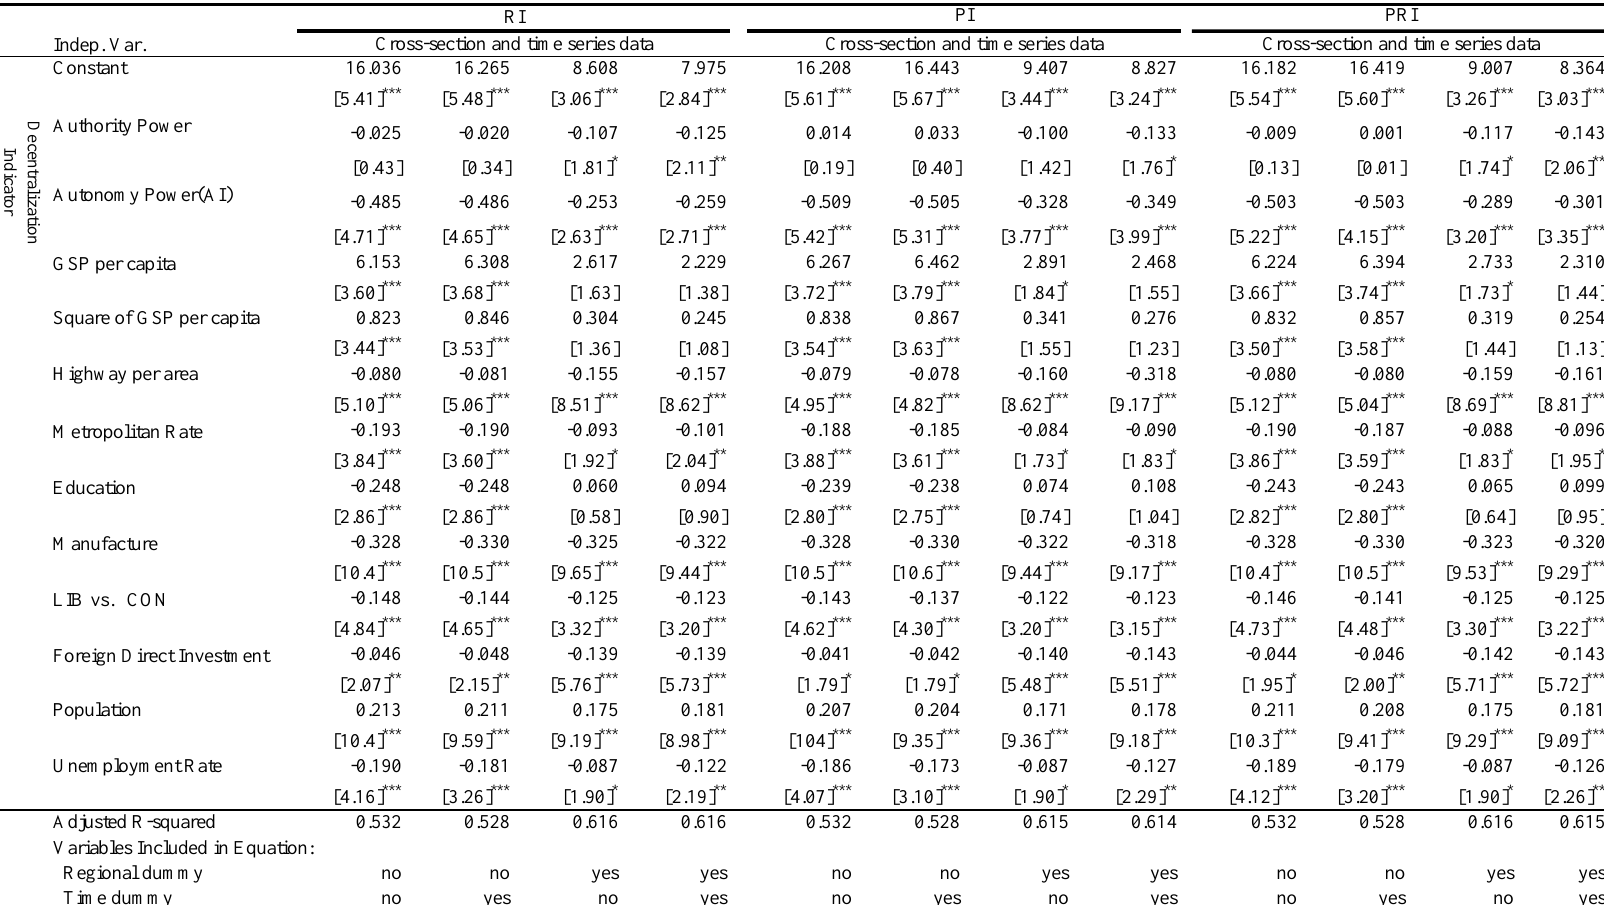
Table 2: Estimation Result (Inequality = GINI Coefficient) Method =